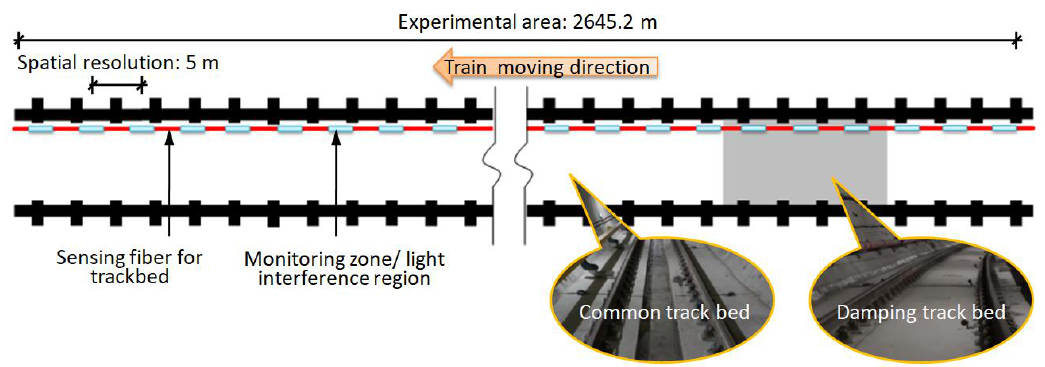
Figure 4. Schematic diagram of experimental area covering different track bed structures.